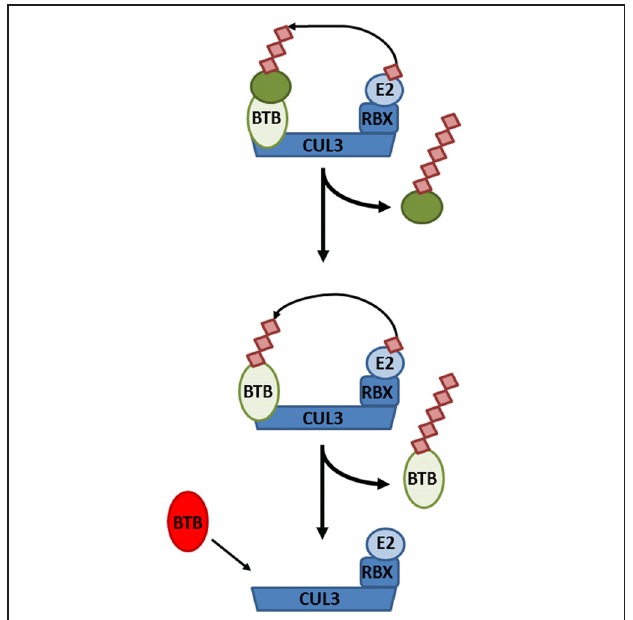
FIGURE 3 | Cullin-RING ligase 3 (CRL3) autoubiquitinationand adaptor switching. (Top) A target substrate (dark green circle) is polyubiquitinated and targeted for degradation by CRL3, consisting of the CUL3 backbone, Bric-à-brac, Tramtrack, and Broad complex (BTB) domain-containing adaptor, RING-Box protein (RBX), and an E2 conjugating enzyme. (Middle) After all available substrates have been polyubiquitinated and degraded, the BTB adaptor itself becomes subject to autoubiquitination and degradation. (Bottom) Consequently, the CRL3 can now switch to a new BTB adaptor in order to polyubiquitinate different substrates.